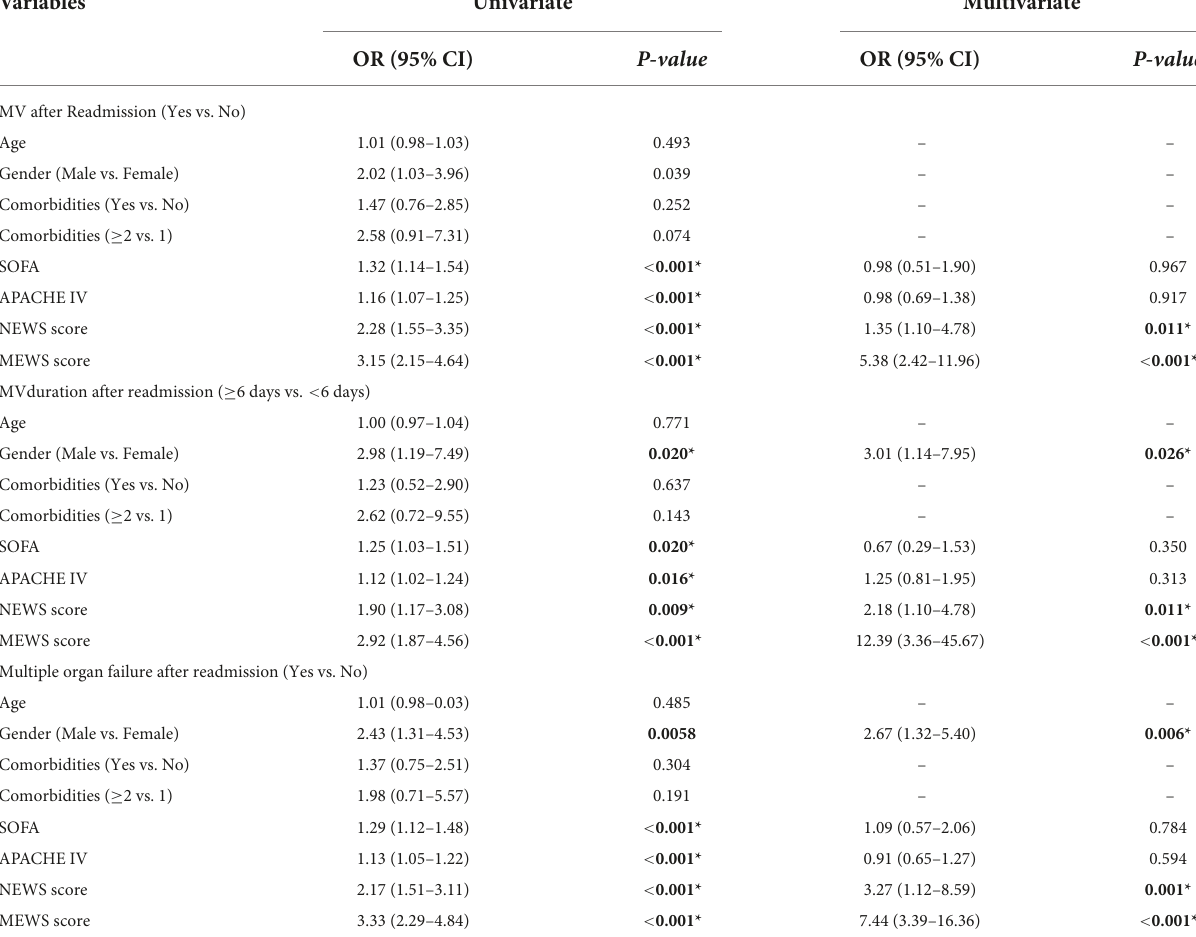
TABLE 5 Univariable and multivariable binary logistic regression analysis to evaluate associations of NEWS and MEWS scores to predict MV status, MV duration, and organ failure after readmission. Variables